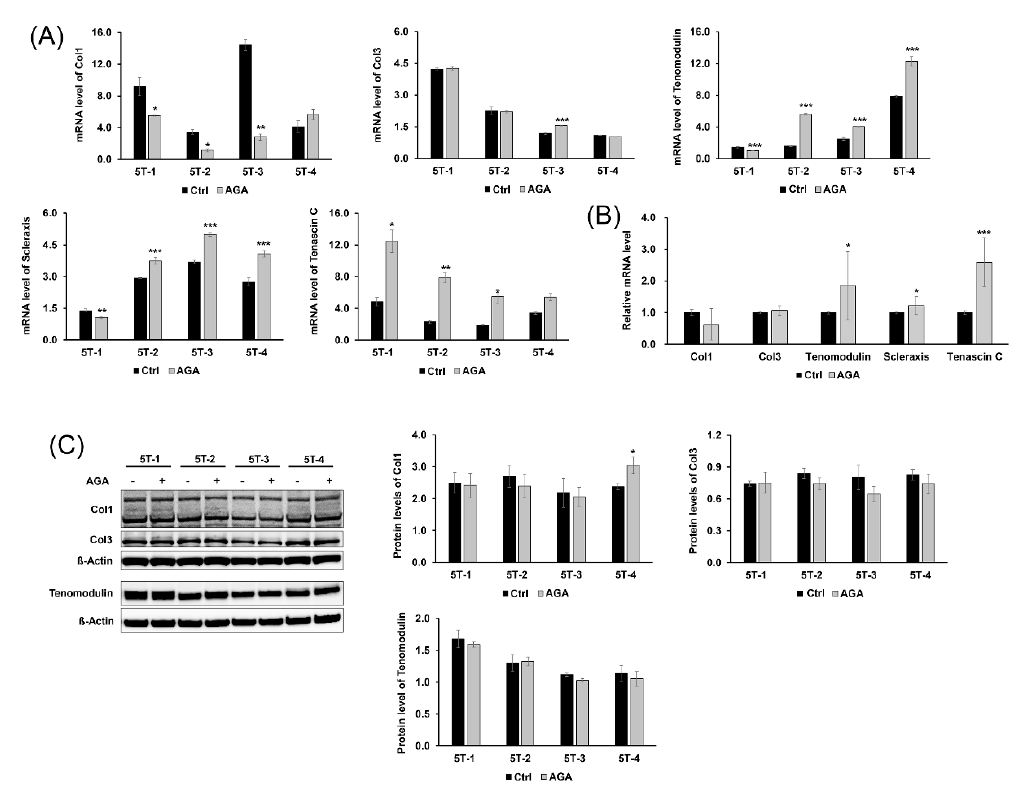
Figure 3. E ff ect of AGA on tenogenic di ff erentiation and regenerative capacity of TDSCs. ( A ) mRNA levels of collagen type I (Col1), collagen type III (Col3), tenomodulin, scleraxis, and tenascin-C were measured by qRT-PCR. ( B ) AGA increased mRNA levels of tenogenic di ff erentiation marker in the AGA group, whereas the treatment had no e ff ects on regenerative capacity. The relative mRNA level represents the value divided mRNA level of the AGA treatment group by mRNA level of the control group in all of the cells. ( C ) Western blot analysis was used to measure protein levels of collagen type I, collagen type III, and tenomodulin. AGA had no e ff ects on tenogenic di ff erentiation and regenerative capacity in the expression of protein levels. mRNA level represents mRNA expression levels standardized to β -actin and protein level represents normalized protein expression level by β -actin. Error bars represent the standard deviation of mean. * p < 0.05, ** p < 0.01, *** p < 0.001, compared with AGA group and control